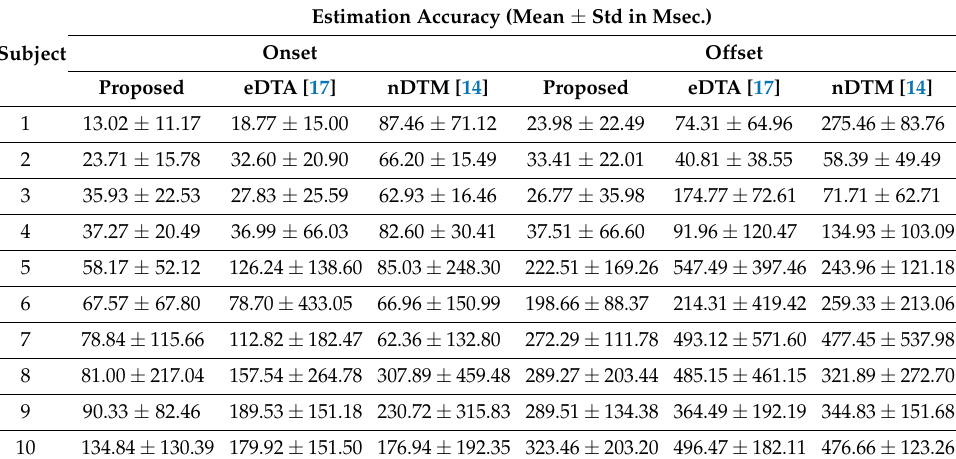
Table 1. Results of the proposed method and two conventional methods for the 10